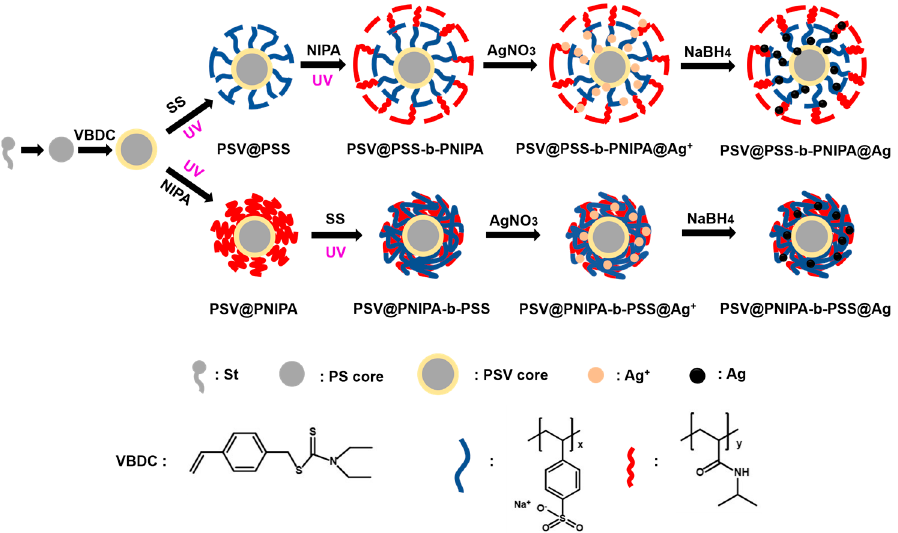
Figure 1. Schematic illustration of PSV@PSS-b-PNIPA@Ag and PSV@PNIPA-b-PSS@Ag.